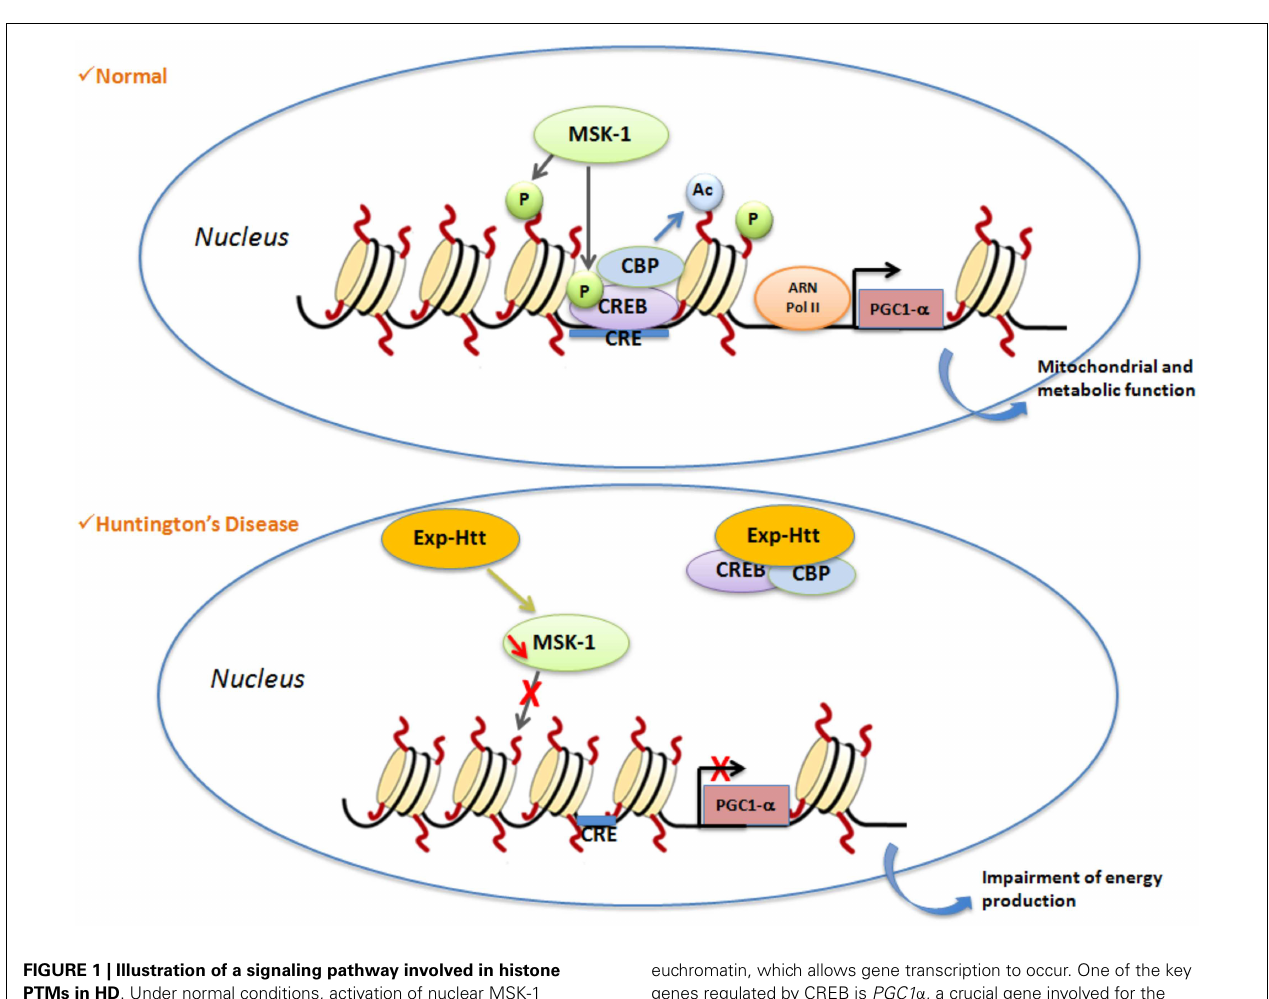
FIGURE 1 | Illustration of a signaling pathway involved in histone PTMs in HD . Under normal conditions, activation of nuclear MSK-1 induces phosphorylation of (1) histone H3 and (2) the transcriptional factor CREB. Phosphorylated CREB recruits CBP, and activates its histone acetyl transferase (HAT) properties. Post-translational modifications (PTM) of histones (phosphorylation, acetylation) lead to modification of chromatin structure from heterochromatin to